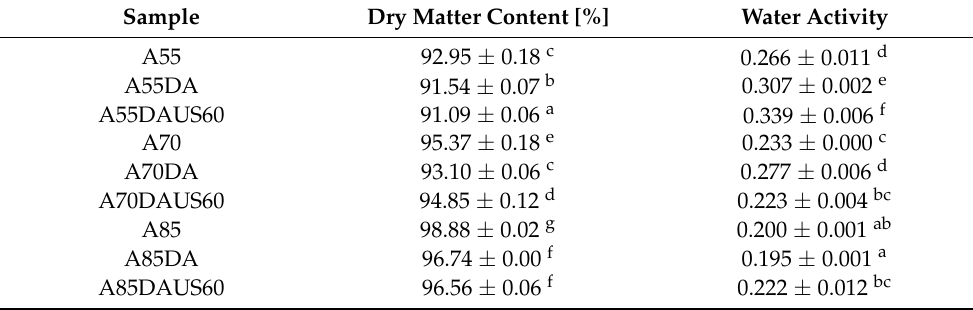
Table 1. Dry matter content and water activity of dried apples obtained by the convective method with non-dehumidified air (A55, A70, A85), dehumidified air (A55DA, A70DA, A85DA), and de- humidified air with ultrasound pretreatment (A55DAUS60, A70DAUS60, A85DAUS60); the same letters (a, b, etc.) in the columns represent homogeneous groups in statistical terms ( α = 0.05). Sample Dry Matter Content [%] Water Activity A55 92.95 ± 0.18